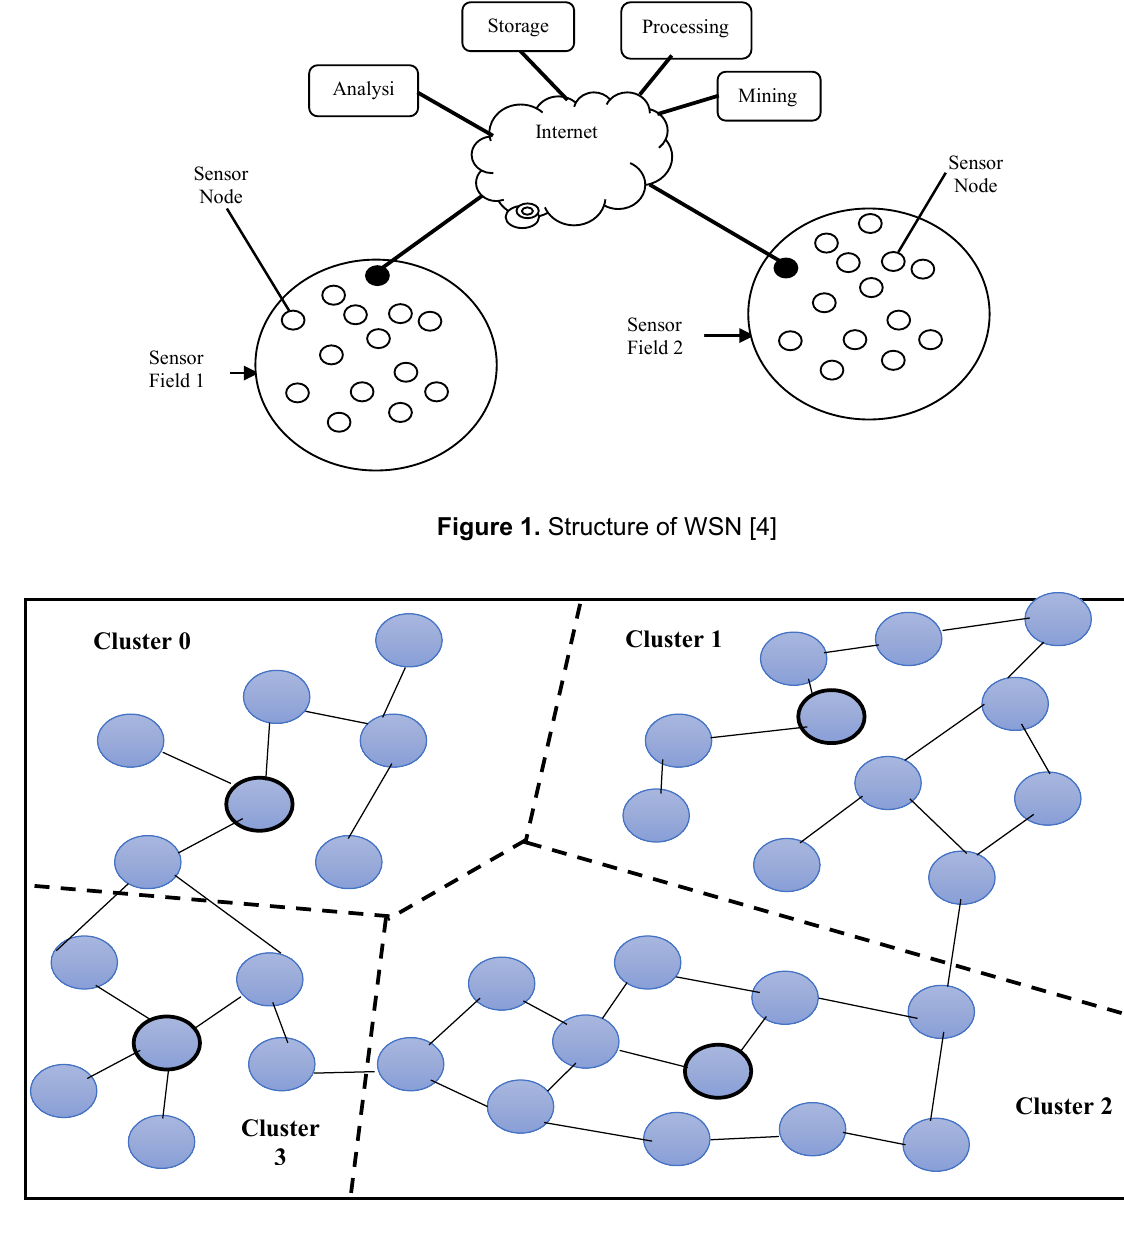
Figure 2. Clustering